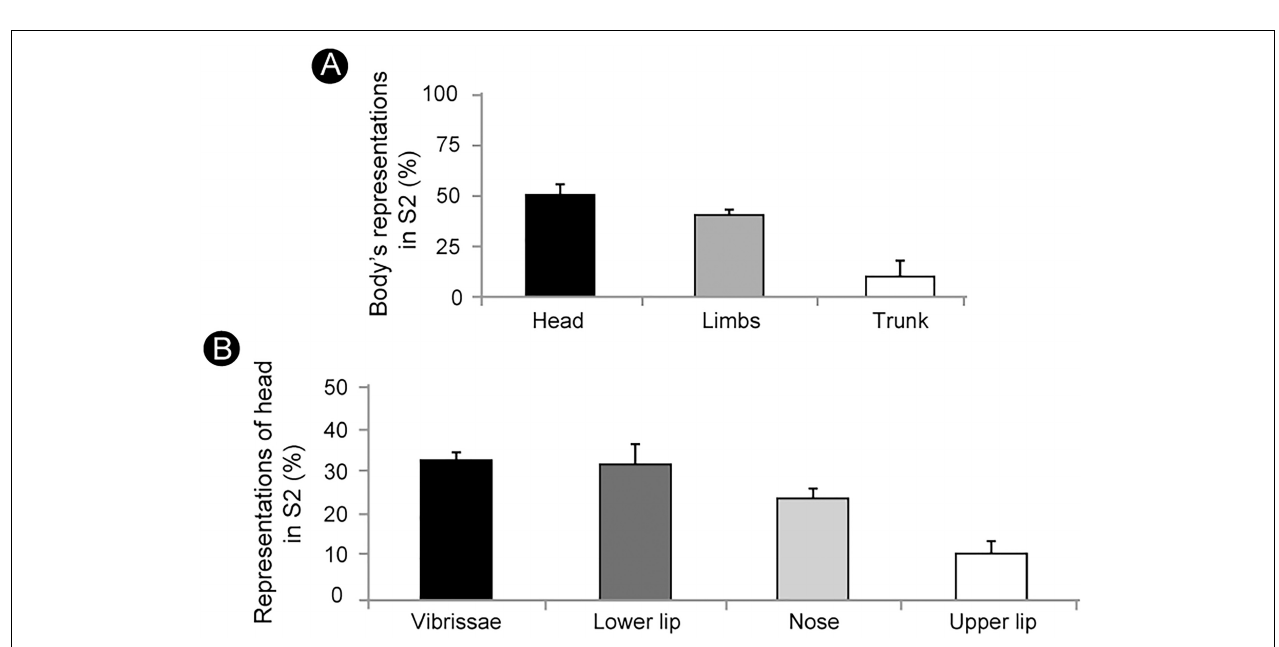
FIGURE 5 | The cortical area occupied by the representation of different body parts in S2. (A) About half of S2 is devoted to the representation of the head, followed by the representation of limbs (forelimb: 23%; hindlimb: 17%) and trunk (10%). (B) Vibrissae (33%) and lower lip (32%) represent two thirds of the head’s representation, followed by the nose (24%) and upper lip (11%) (mean ± SEM).